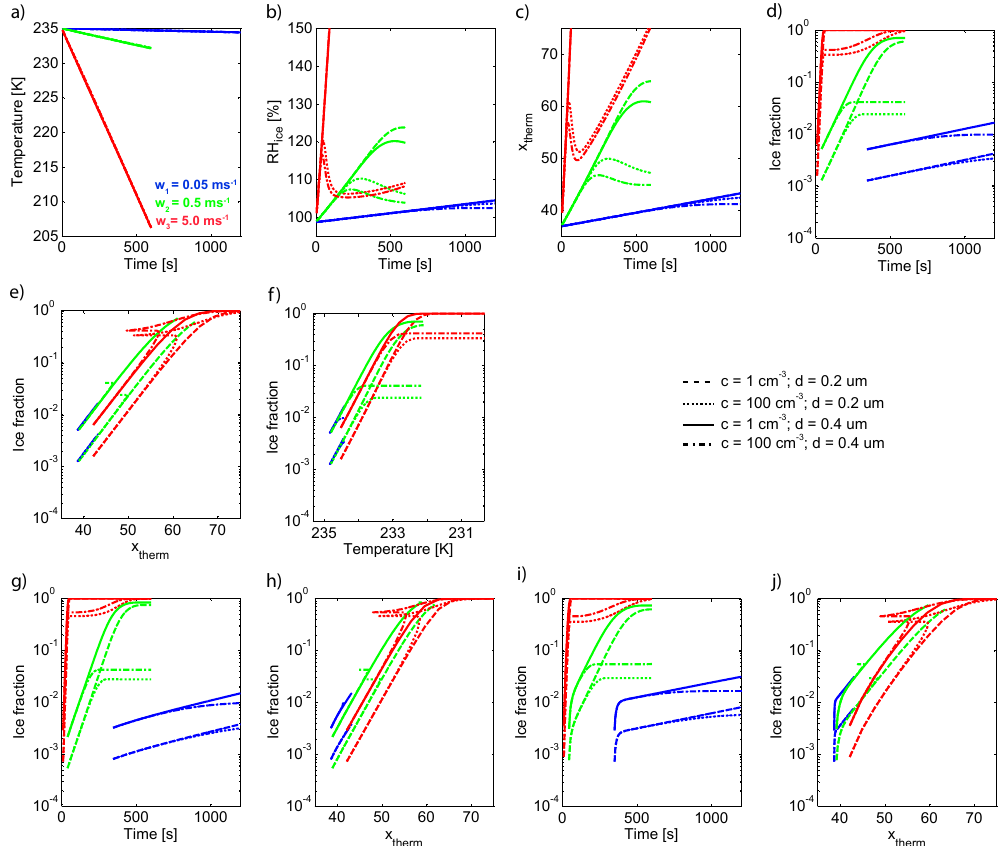
Figure 9. Time series for calculations with the box model ACPIM: parcel runs with varying updraft velocities (indicated by color as noted in panel a ) for investigating the influence of aerosol concentration and the aerosol median diameter on the observed ice-active fractions; all runs start at T = 235K and S wat = 0 . 68 – the first panels (a–c) show temperature, relative humidity and the composite variable x therm ; for the subfigures ( d ), ( e ) and ( f ) ice nucleation is parameterized by Eq. (16), whereas for ( g ) and ( h ) Eq. (19) was used and for ( i ) and ( j ) Eq. (21) was used